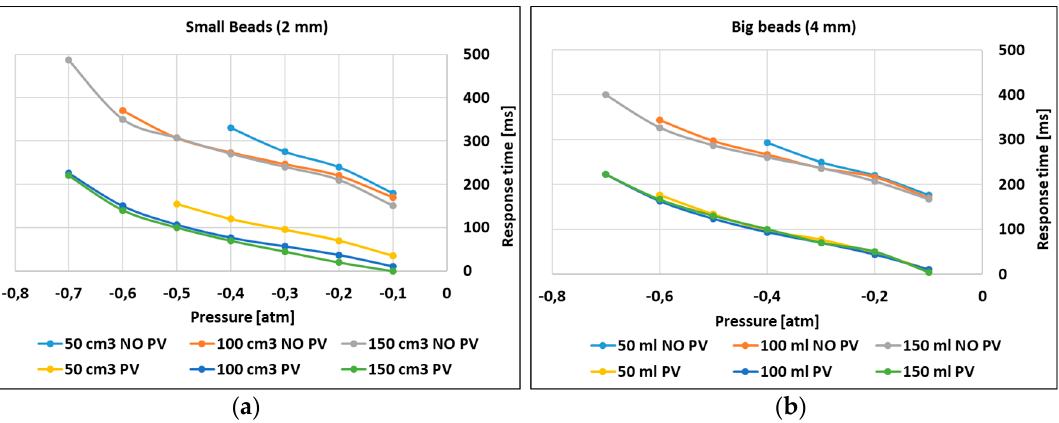
Figure 7. ( a ) The engaging response time of TBCs with small bumps. ( b ) The engaging response time of TBCs with large bumps (standard deviation ±3–8 ms). Both types of samples were tested in two different conditions; one based on ambient pressure and one based on a pre-charged pressure of − 0.01 atm.